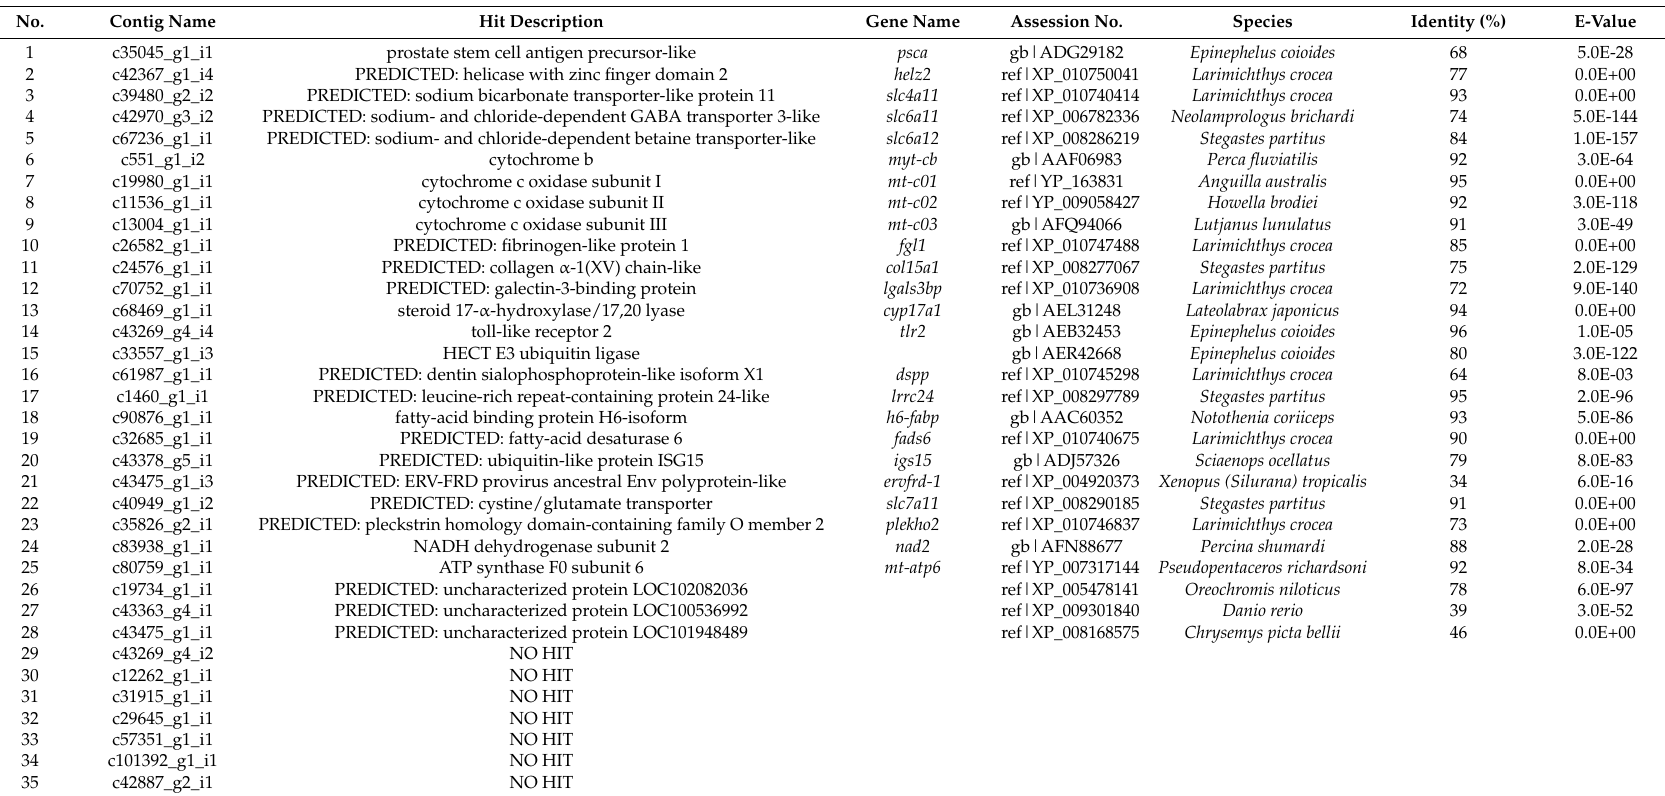
Table 3. Identification and annotation of differentially expressed genes (n = 35 within the FDR of 0.05) in the ovary of h¯apuku ( Polyprion oxygeneios ) during previtellogenic (March) and early vitellogenic (May) stages of oogenesis.